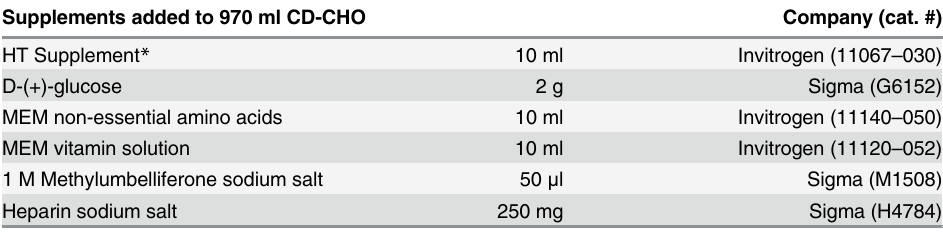
Table 1. Composition of optimized chemically defined protein free medium (OCDPF medium). Supplements added to 970 ml